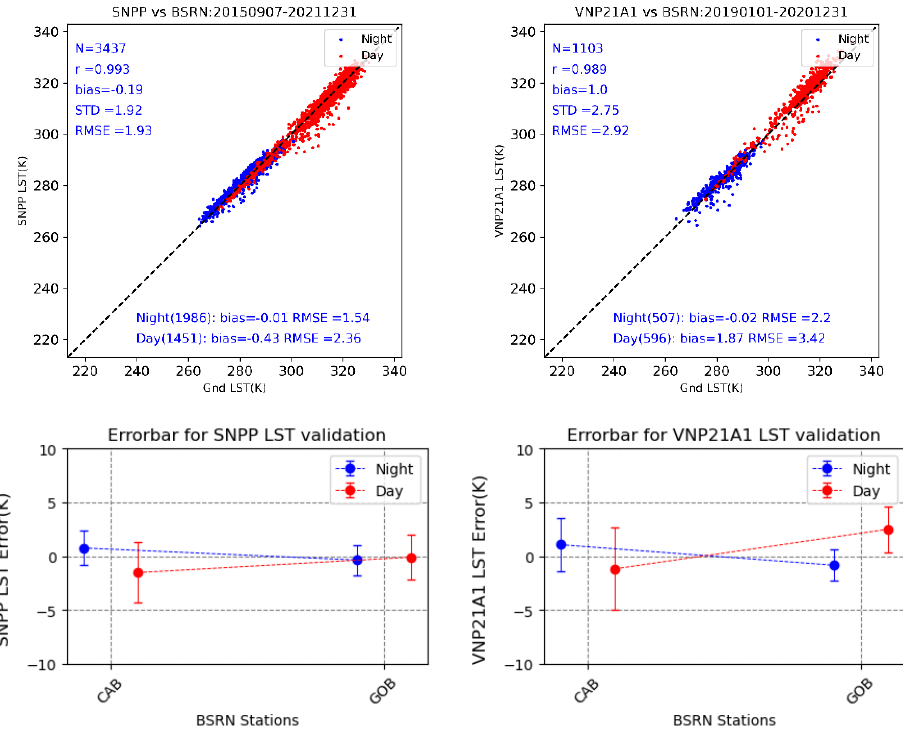
Figure 7. LST validation against BSRN data for SNPP ( left ) and VNP21A1 ( right ) with the overall valuation result at top and site-wide results at the bottom.